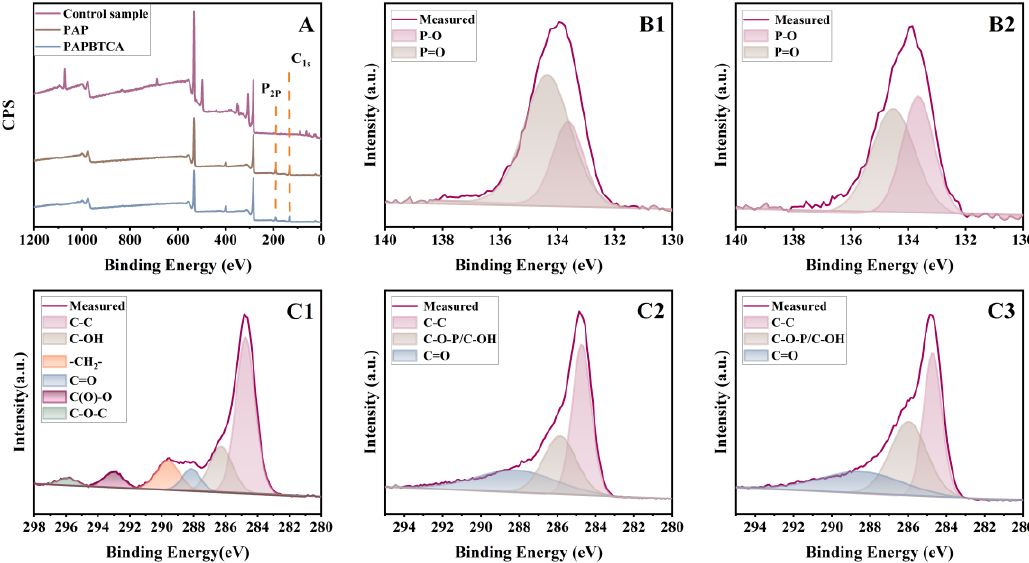
Figure 7. XPS spectra of char residue ( A ), P2p of PAP-200 ( B1 ), P2p of PAPBTCA-200 ( B2 ), C1s of control cotton ( C1 ), C1s of PAP-200 ( C2 ), and C1s of PAPBTCA-200 ( C3 ). control cotton ( C1 ), C1s of PAP-200 ( C2 ), and C1s of PAPBTCA-200 ( C3